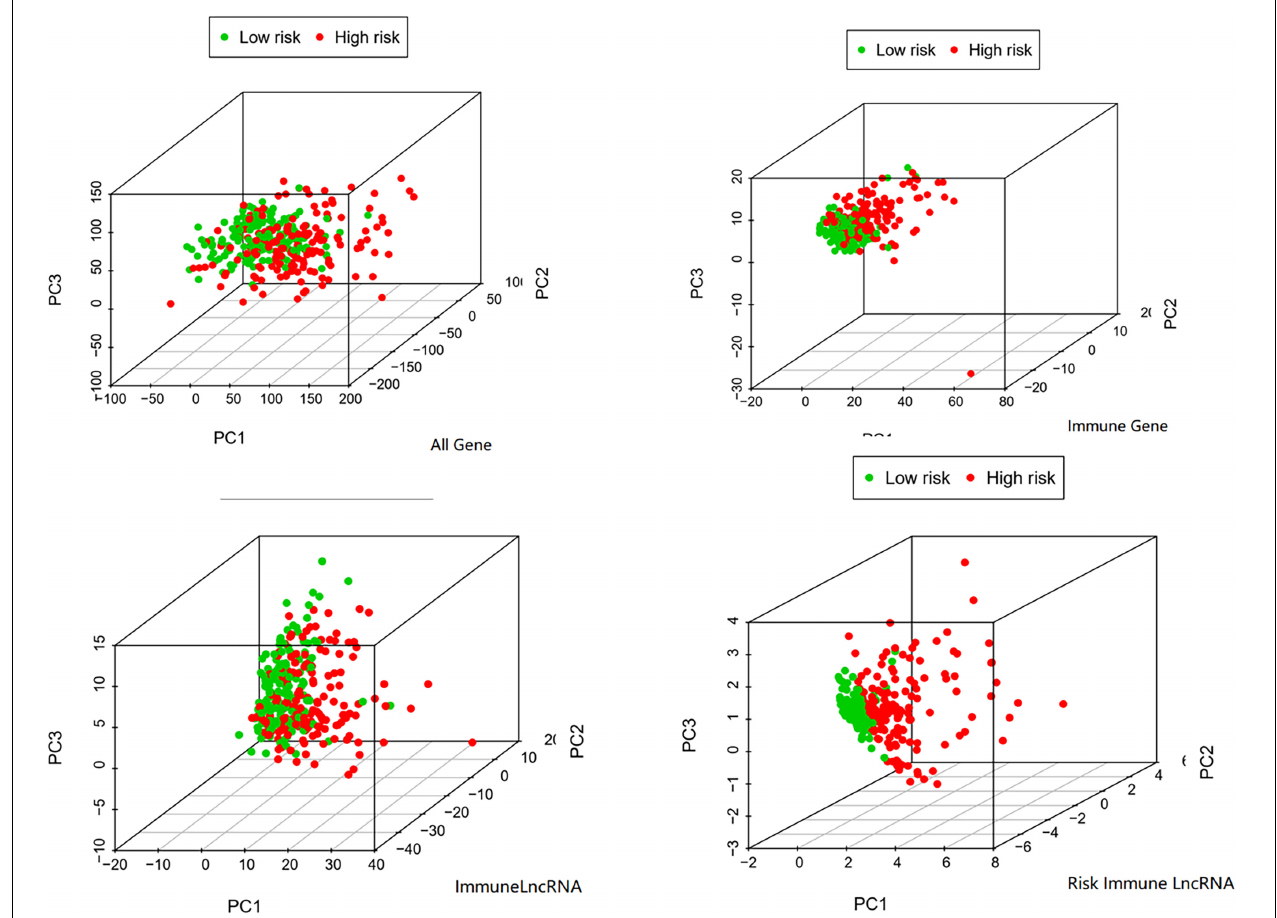
FIGURE 4 | PCA among all genes, immune genes, immune LncRNA, and risk immune